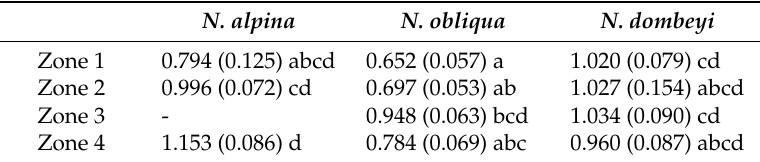
Table 6. Least square means (standard errors in parentheses) statistics of pairwise Tukey comparisons between all 11 groups in the CV + SpZone model (Equation (9)).